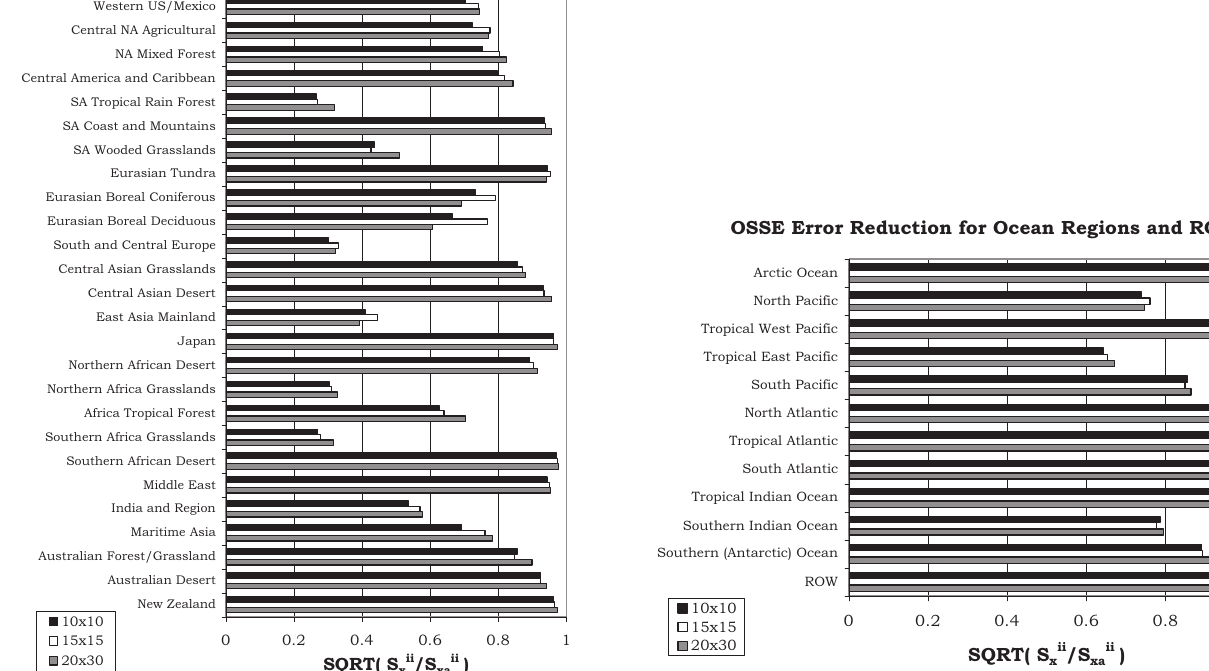
Fig. 16. OSSE uncertainty ratios for the land, ocean and ROW regions at 3 different resolutions (10 ◦ × 10 ◦ , 15 ◦ × 15 ◦ and 20 ◦ × 30 ◦ ). Lower ratios indicate a larger error reduction.